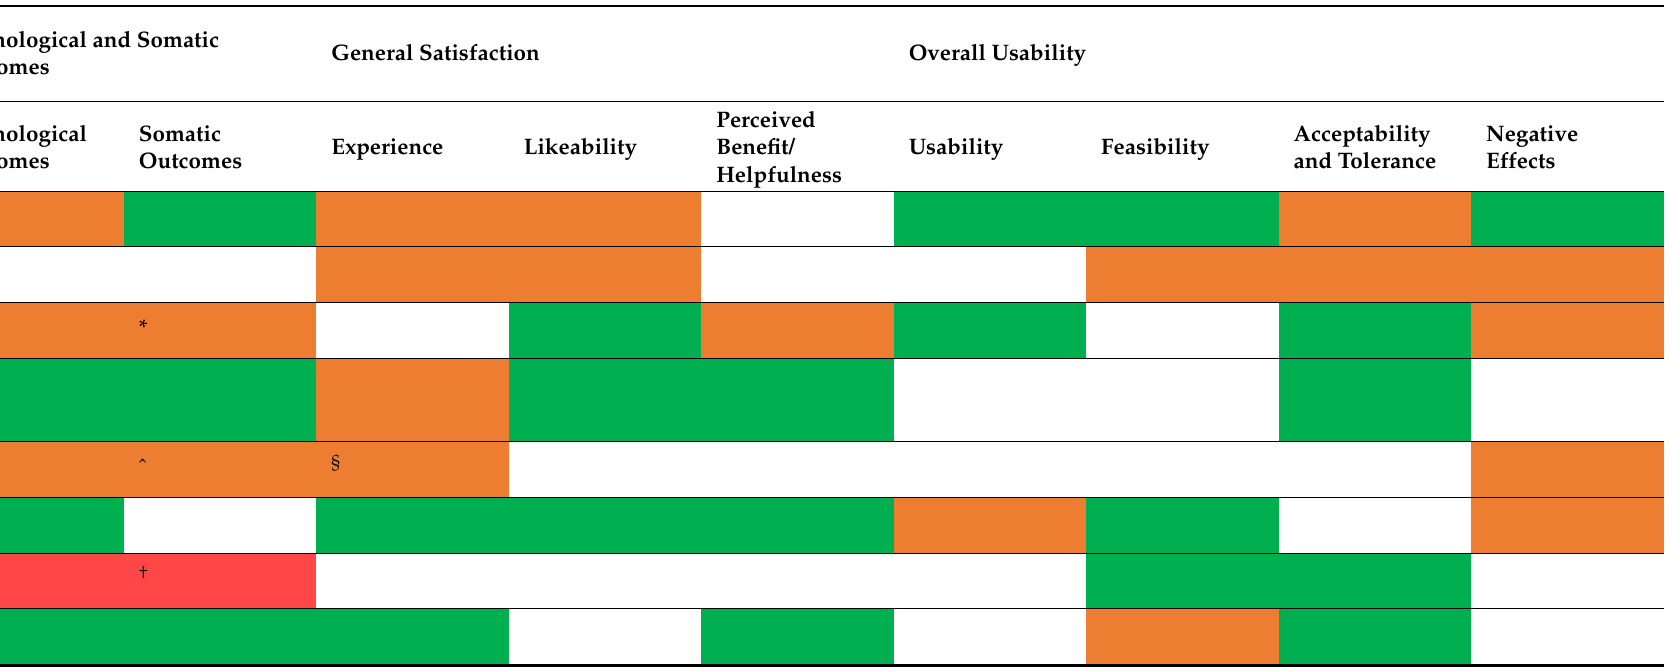
Table 2. Virtual Reality in Palliative Care: Primary and Secondary